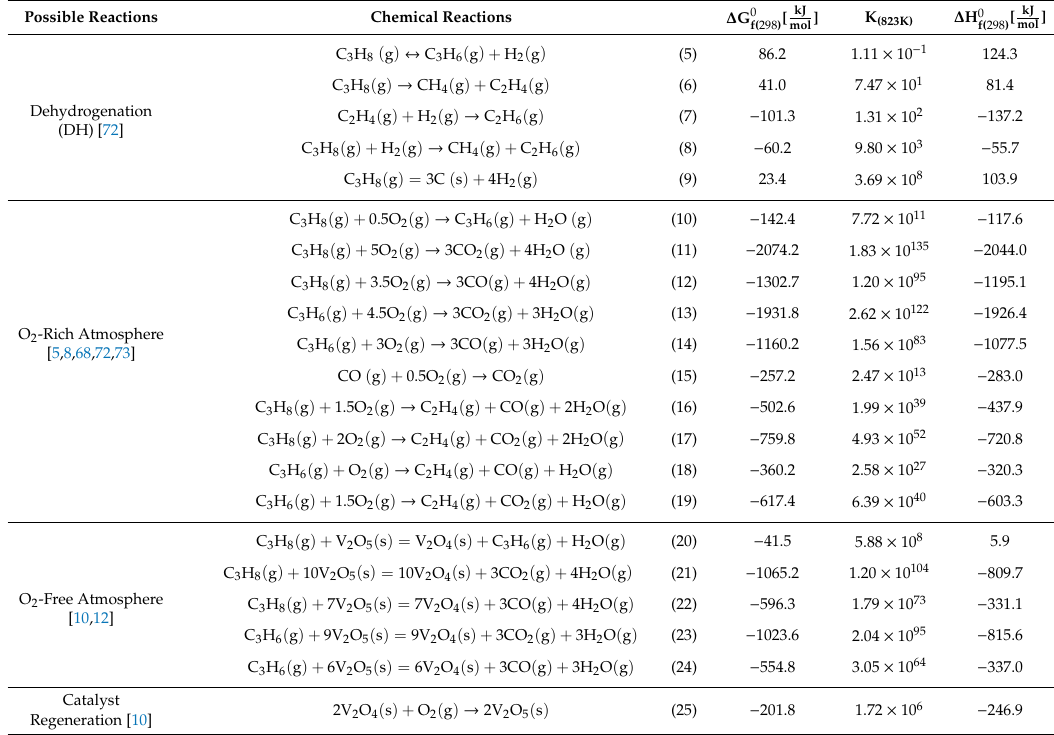
Table 1. Gibbs Free Energy and Enthalpy Changes for Propane Dehydrogenation (DH) and Oxidative Dehydrogenation (ODH)